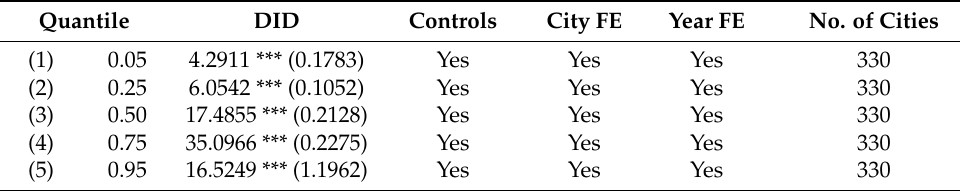
Table 7. Heterogeneity analysis: differences in distribution based on quantile